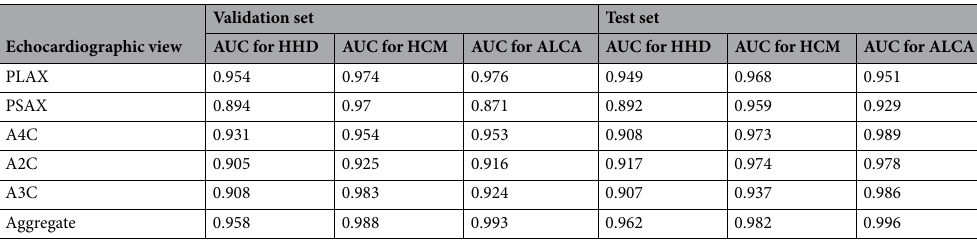
Table 3. AUCs for the differential diagnosis of LVH. The AUC for each differential diagnosis (HHD, HCM and CA) was calculated in the validation (n = 155) and test sets (n = 155). A2C apical 2-chamber view, A3C apical 3-chamber view, A4C apical 4-chamber view, PLAX parasternal long-axis view, PSAX parasternal short-axis view, AF atrial fibrillation, BMI body-mass index, ALCA light-chain cardiac amyloidosis, EDD end- diastolic dimension, EDV end-diastolic volume, EF ejection fraction, ESD end-systolic dimension, ESV end- systolic volume, HHD hypertensive heart disease, HCM hypertrophic cardiomyopathy, IVSd interventricular septum at end-diastole, LVPWd left ventricular posterior wall thickness at end-diastole, LVWTmax end- diastolic maximal LV wall thickness, LA left atrium, LAVI left atrial volume index, LV left ventricular, MI mass index, N/A not applicable, PASP pulmonary artery systolic pressure, TR tricuspid